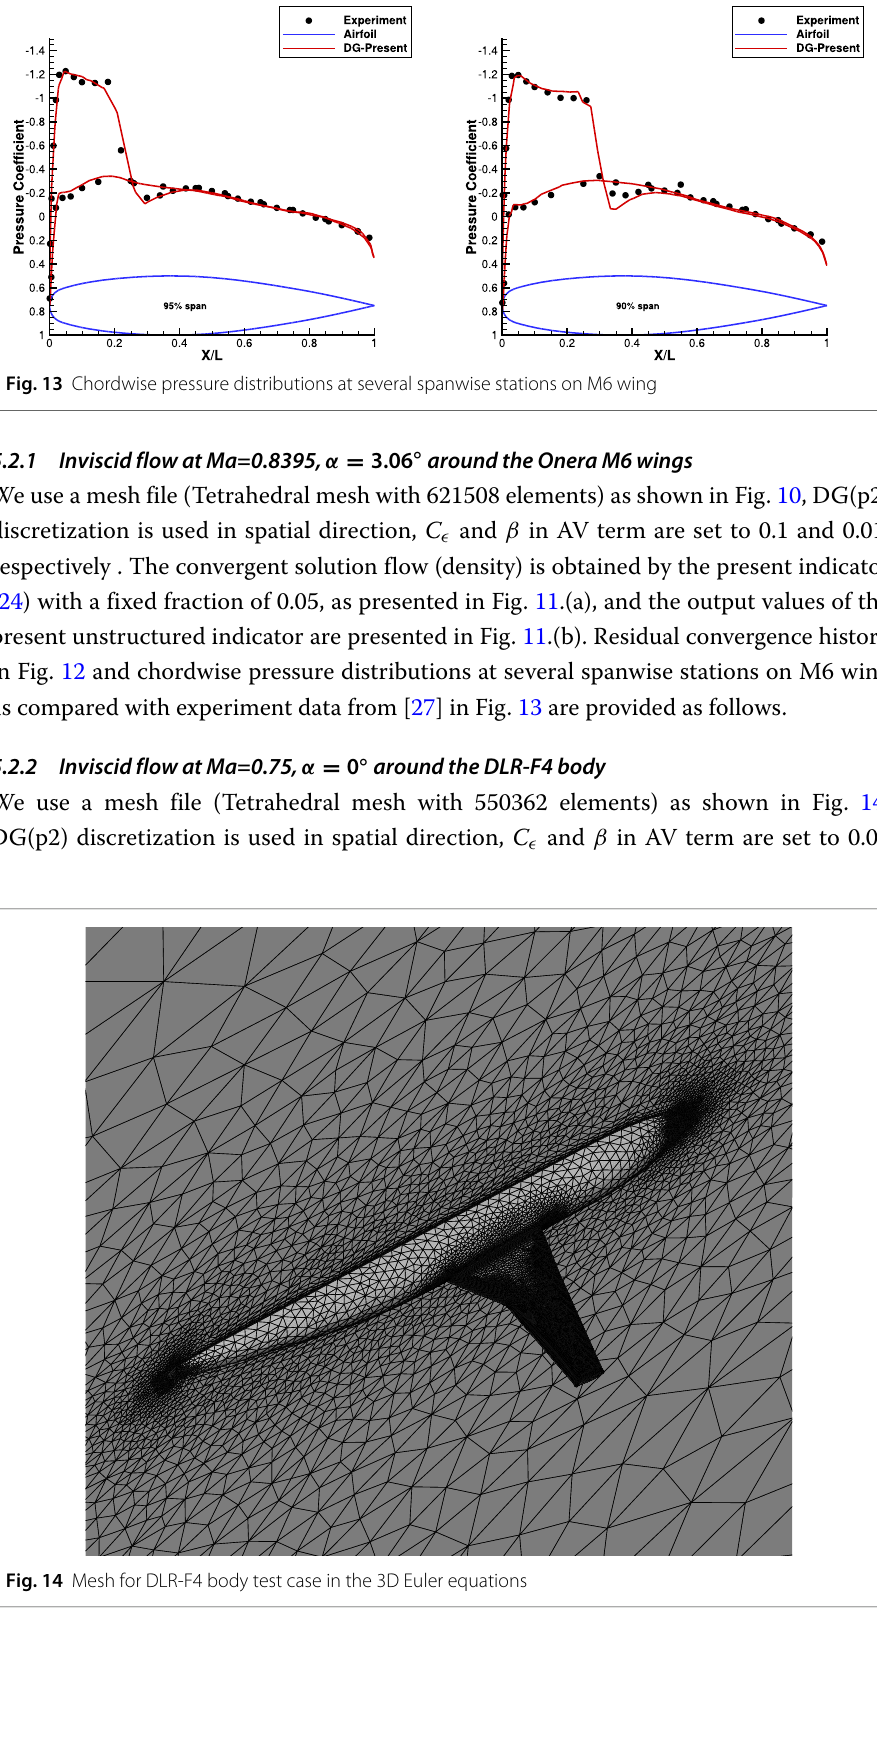
Fig. 13 Chordwise pressure distributions at several spanwise stations on M6 wing